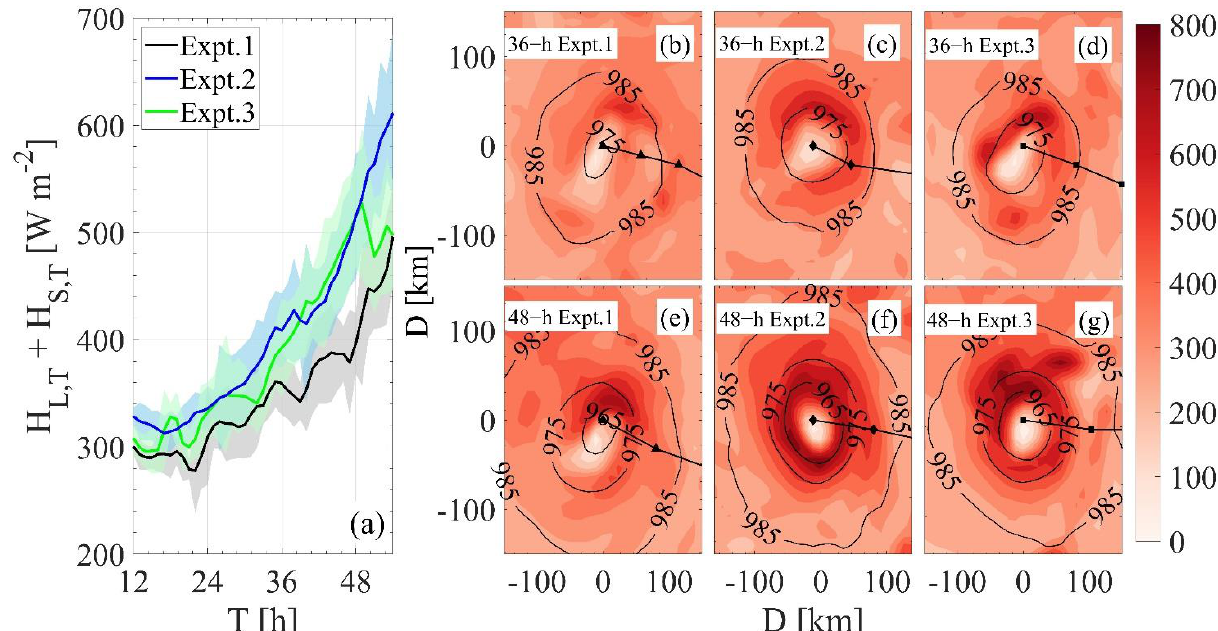
Figure 4. ( a ) The integrated air–sea total heat fluxes with the simulation time for the Expt.1, Expt.2, and Expt.3. Solid lines and shadows mark the mean and standard deviation of the area-averages within two times of the radius of maximum wind (RMW) from the center of TCs for the numerical experiments. ( b – d ) The spatial distributions of air–sea total heat fluxes (shadowing at the interval of 10 W m −2 ) and sea level pressure (SLP) (contouring at the interval of 10 hPa) with the 6 h TC tracks (black line with the triangle, diamond, and square markers) after 36 h simulation for Expt.1, Expt.2, and Expt.3, respectively. ( e – g ) The spatial distributions of air–sea total heat fluxes (shadowing at the interval of 10 W m −2 ) and sea level pressure (SLP) (contouring at the interval of 10 hPa) with the 6 h TC tracks (black line with the triangle, diamond, and square markers) after 48 h simulation for Expt.1, Expt.2, and Expt.3, respectively. Note, the tracks of TC are from the right to the left following the black line.